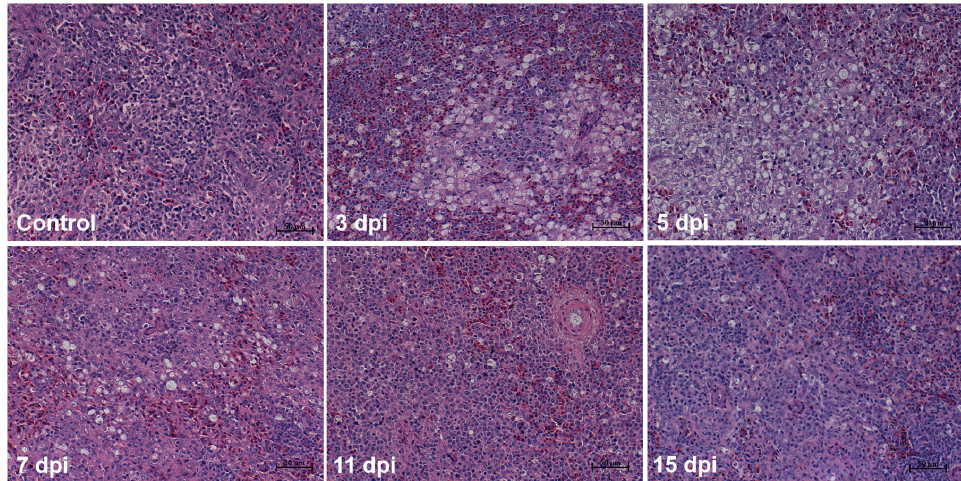
Figure 3. Histopathological changes in the spleen of goslings infected with GNAstV. Scale bar: 50 µ m.